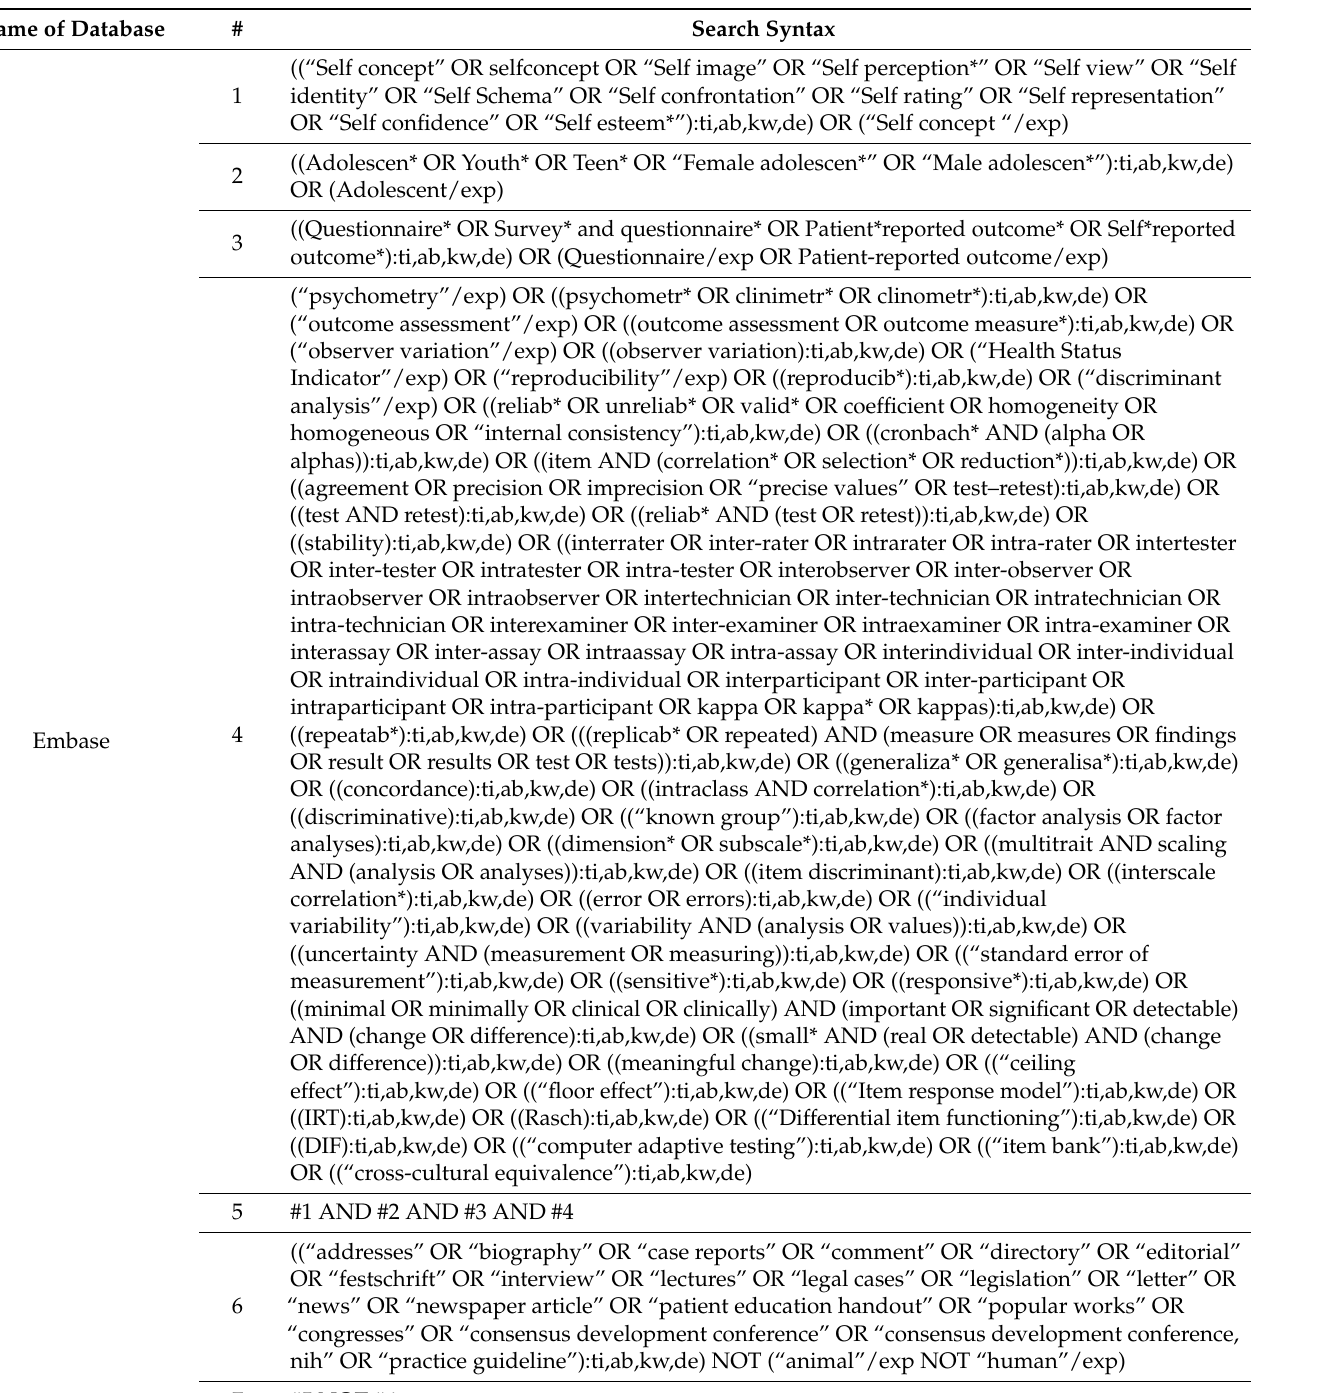
Table A1. Search